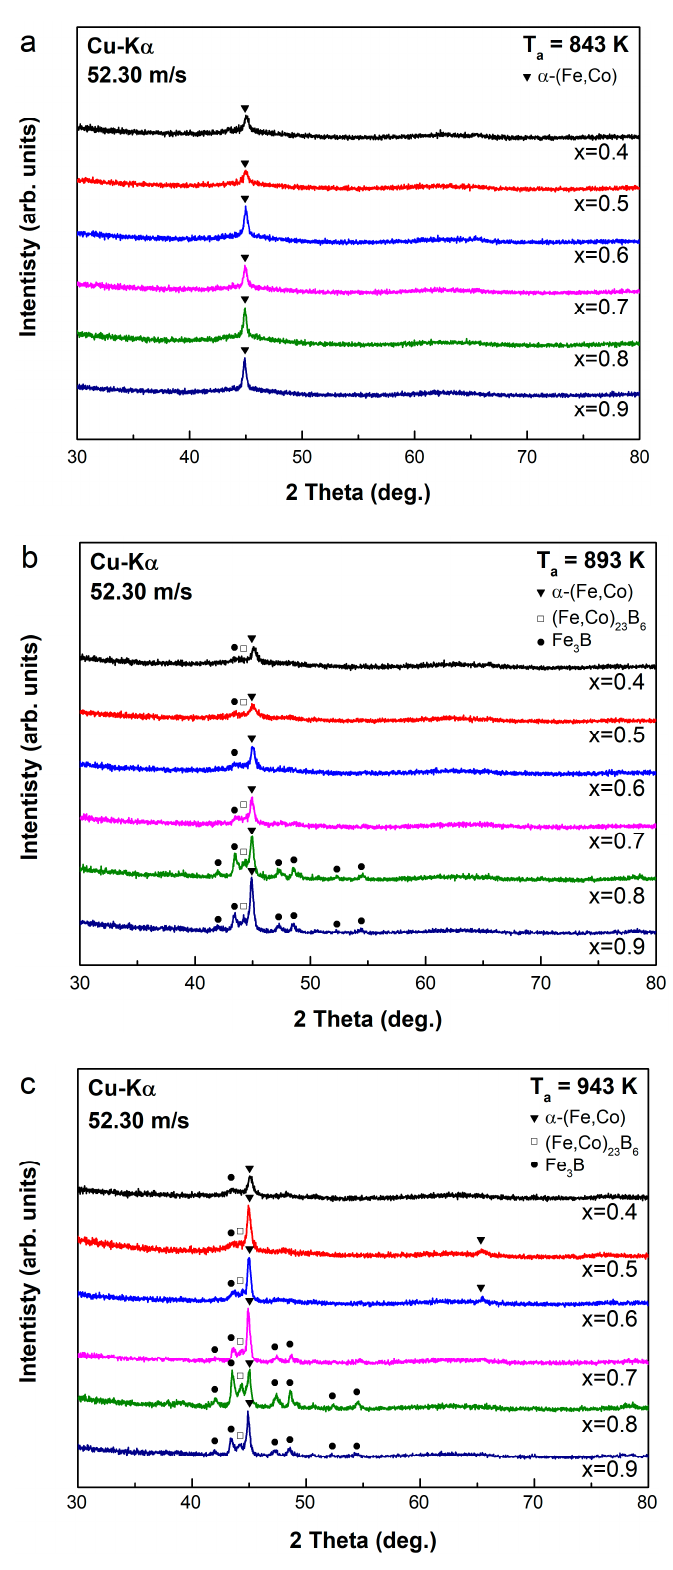
Figure 6. XRD patterns of the annealed (Fe x Co 1 − x ) 72 B 19.2 Si 4.8 Nb 4 (0.4 ≤ x ≤ 0.9, at 0.1 intervals) ribbons for 10 mins at ( a ) 843 K ( b ) 893 K ( c ) 943 K. Referring to Figure 7 and Table 1, the saturated magnetization (M s ) value has increased by about 20 to 30 emu/g by the heat treatment, and generally, the saturation magnetization tends to increase as the annealing temperature increases. For example, in